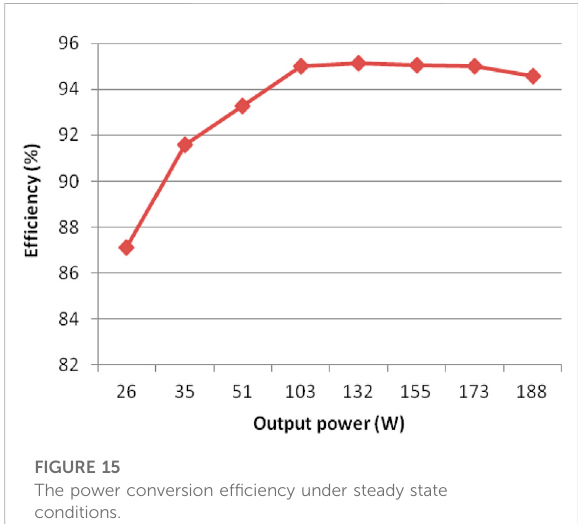
FIGURE 15 The power conversion ef fi ciency under steady state